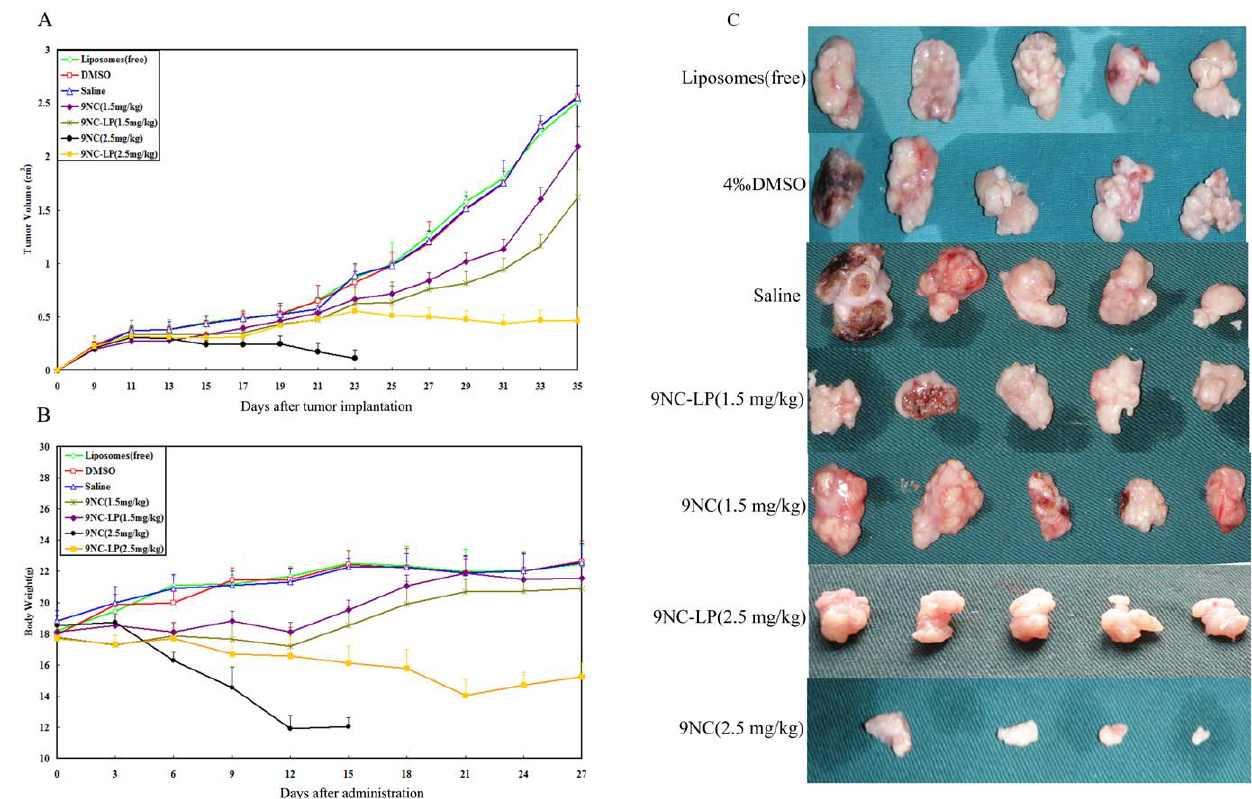
Figure 4. Invivo effects of 9NC and 9NC-LP given to nude mice bearing HepG2 xenograft tumors. Compounds were given i.v. at doses of 1.5 mg/kg/d or 2.5 mg/kg/d on a 5/2/5 (5 days on, 2 days off and 5 days on) schedule for 3 weeks. Tumor size was determined every two day after tumor implantation. Tumor volume (cm 3 )=( w 2 6 l )/2, w =width, l =length of the tumor (A) . (Values presents as means 6 SD. Liposomes (free): p . 0.05; DMSO: p . 0.05; 9NC (1.5 mg/kg): p , 0.05; 9NC-LP (1.5 mg/kg): p , 0.05; 9NC-LP (2.5 mg/kg): p , 0.01; vs. Saline respectively. The data of 9NC (2.5 mg/kg)